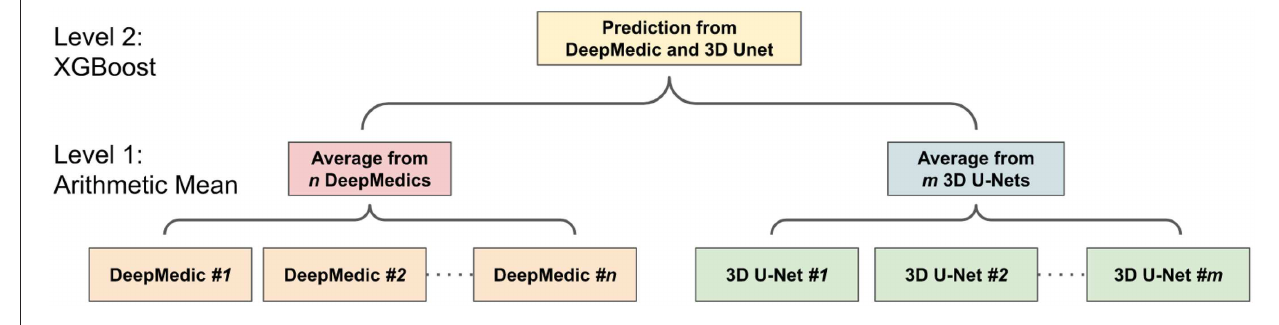
FIGURE 5 | The workflow of two-level ensemble